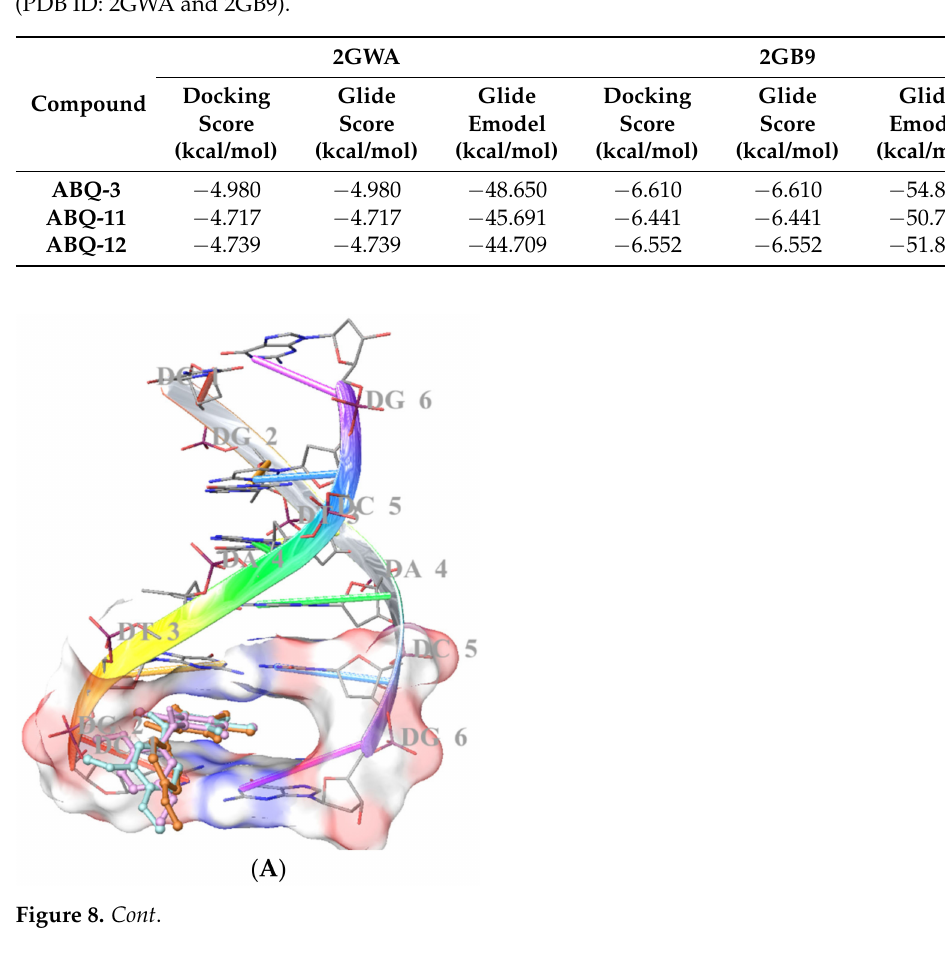
Figure 7. ( A ) Docking poses of ABQ-3 , ABQ-11 , and ABQ-12 and ( B ) docking interactions of ABQ-3 in the minor groove of DNA (PDB ID: 2GWA) ( ABQ-3 , ABQ-11 , and ABQ-12 are colored in orange, plum, and turquoise, respectively). Table 4. The docking score, glide gscore, and glide emodel findings of ABQ-3 , ABQ-11 , and ABQ-12 (PDB ID: 2GWA and 2GB9).